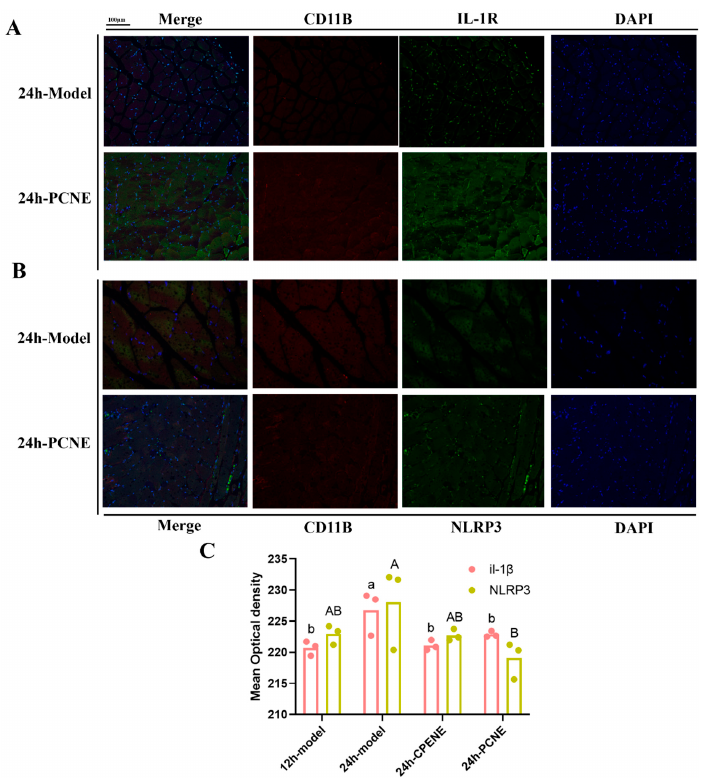
Figure 5. Il-1 β ( A ), NLRP3 ( B ) expression and their mean optical densities ( C ) in different groups. Different letters ("a","b" or "A","B") indicate significant differences ( p < 0.05).